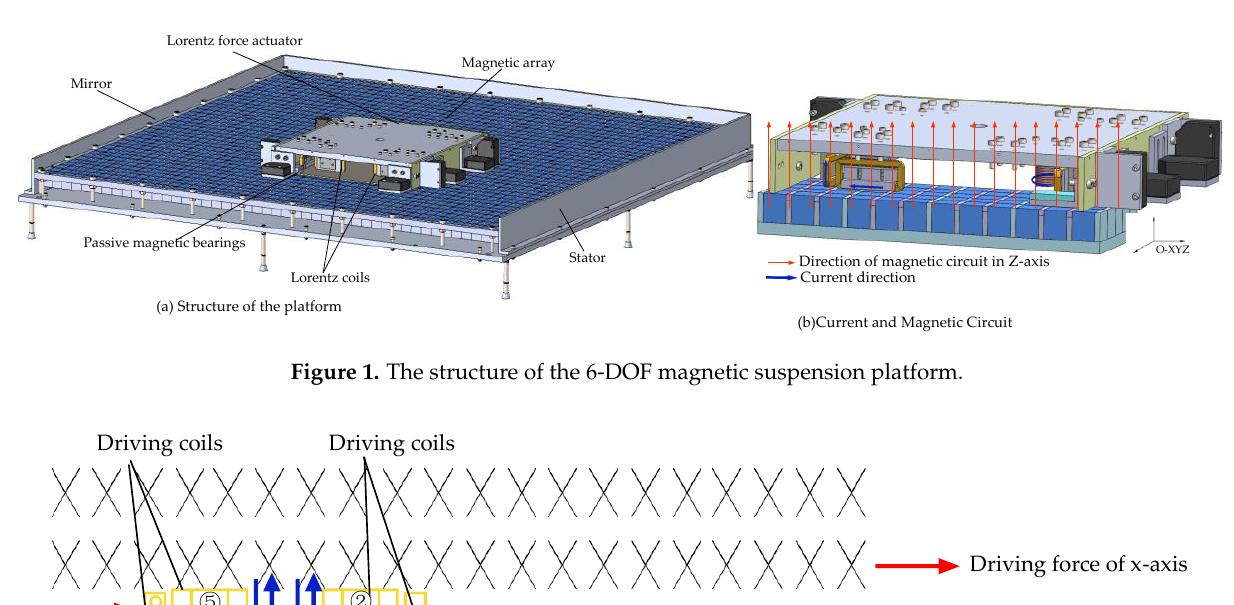
Figure 2. Working principle of the 6-DOF magnetic suspension platform.